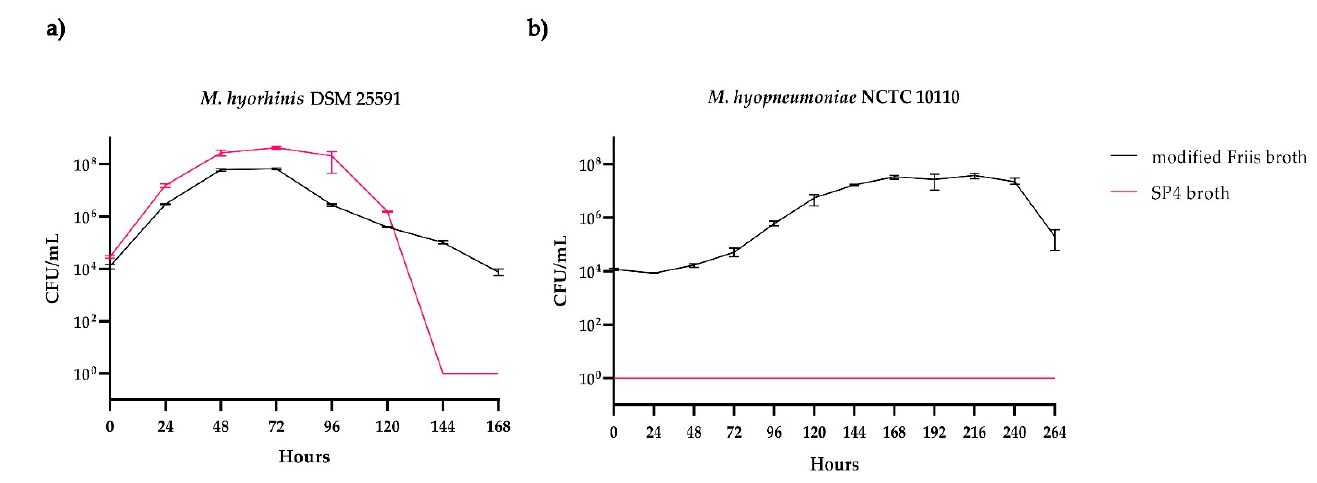
Figure 3. Growth curves of ( a ) M. hyorhinis DSM 25591 and ( b ) M. hyopneumoniae NCTC 10110 cultured in modified Friis broth (black) or SP4 broth (red). Both strains were cultured in triplicates. The cell count was determined on the corresponding agar media.